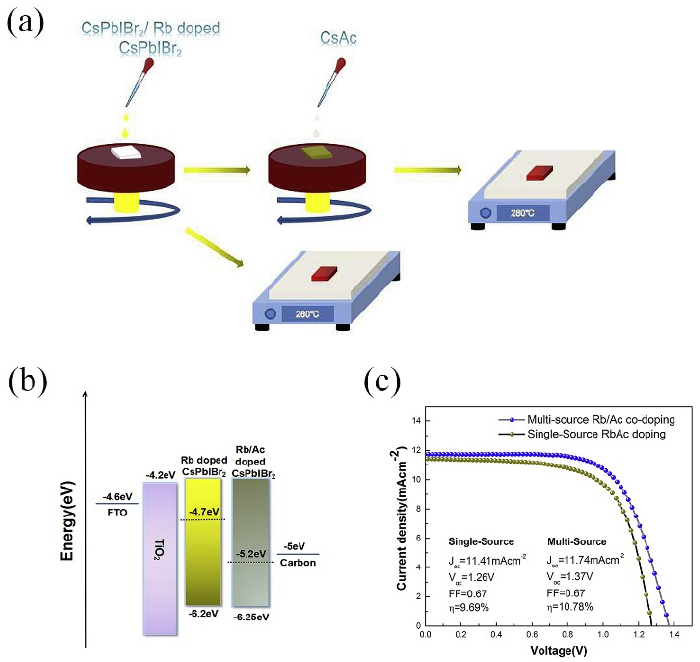
Figure 6. ( a ) Schematic illustration of fabrication of CsPbIBr 2 film by doping the precursor solution with multi-source cation/anion. ( b ) Energy-level diagram of CsPbIBr 2 C-IPSCs with Rb and Rb/Ac doped. ( c ) J–V curves of CsPbIBr 2 C-IPSCs with single-source and multi-source Rb/Ac doped. Reproduced with permission [51]. Copyright 2021, Elsevier Inc Publications.